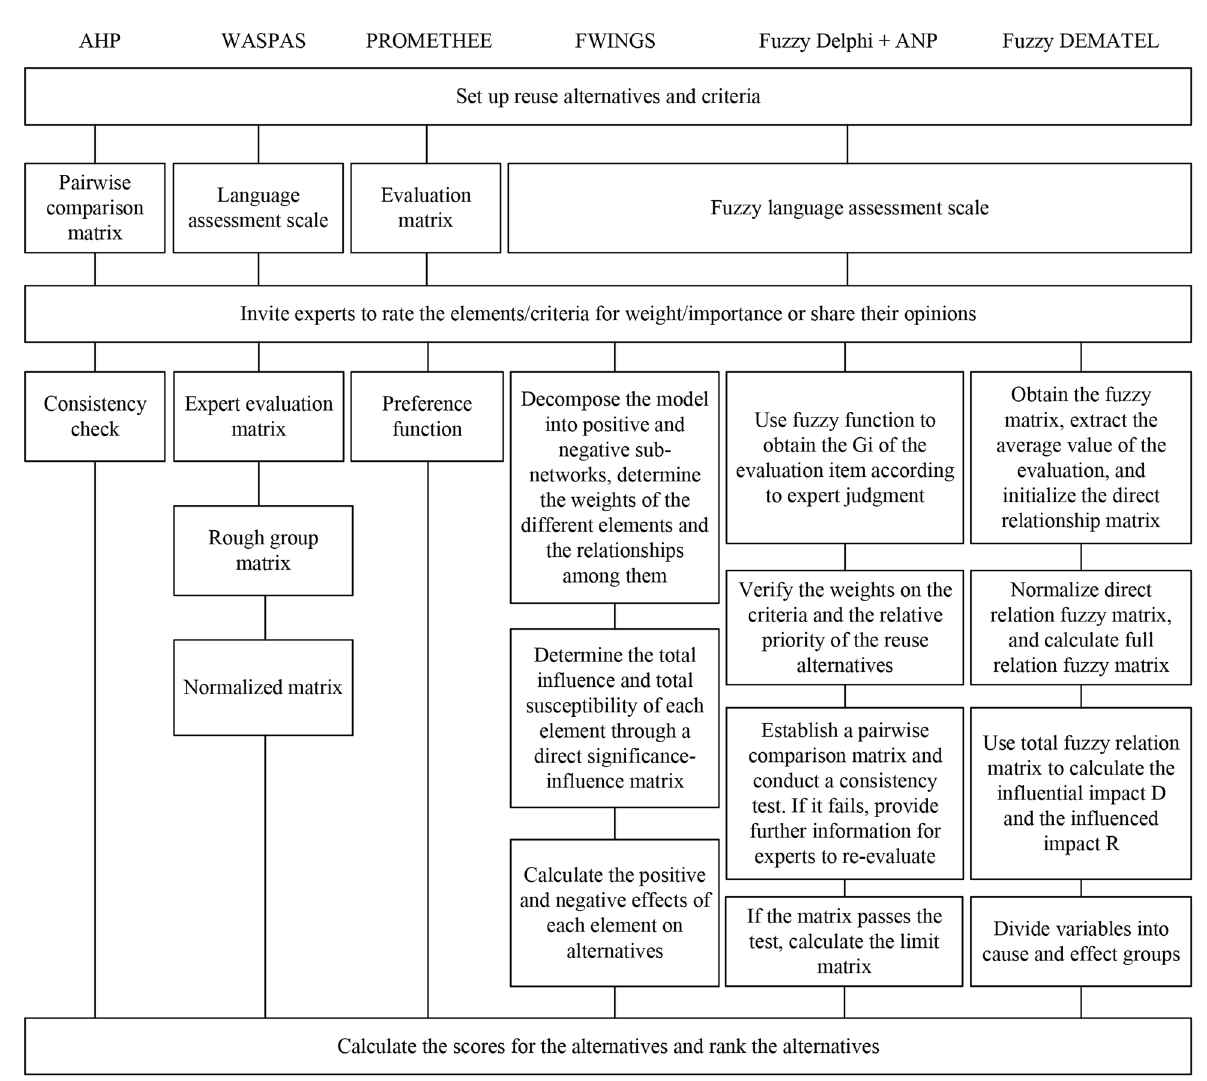
Fig. 9 MCDM applications involving the adaptive reuse of heritage buildings. (Source: The author